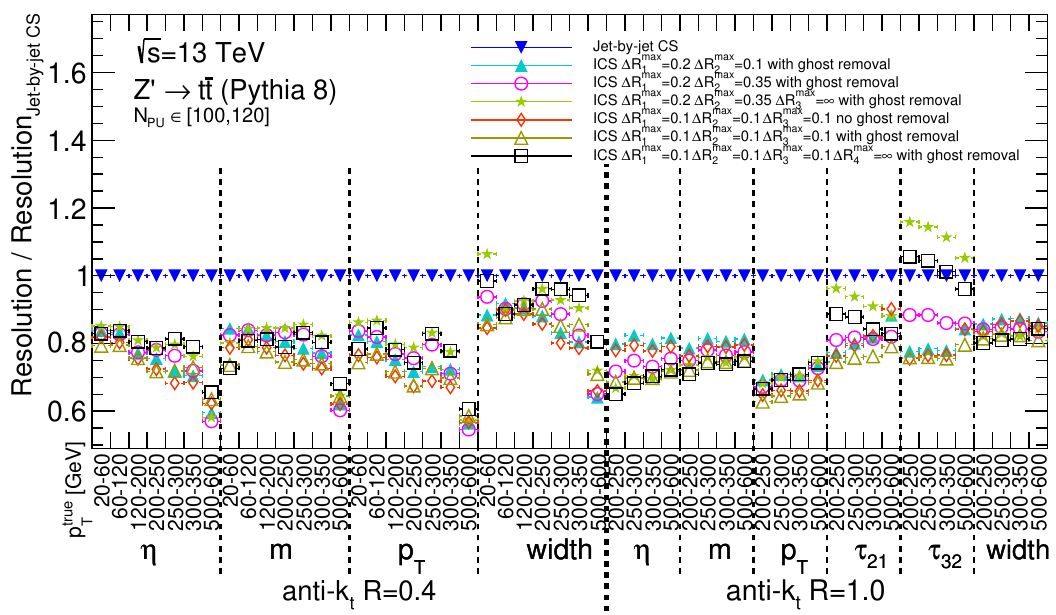
Figure 19. Resolution for a representative set of con(cid:12)gurations for the ICS method with three or more iterations. The (cid:1) R max parameter for the individual iterations is varied and the ghost removal option is used or not. The other CS parameters are set to (cid:11) = 1 and A g = 0 : 0025 for each iteration.